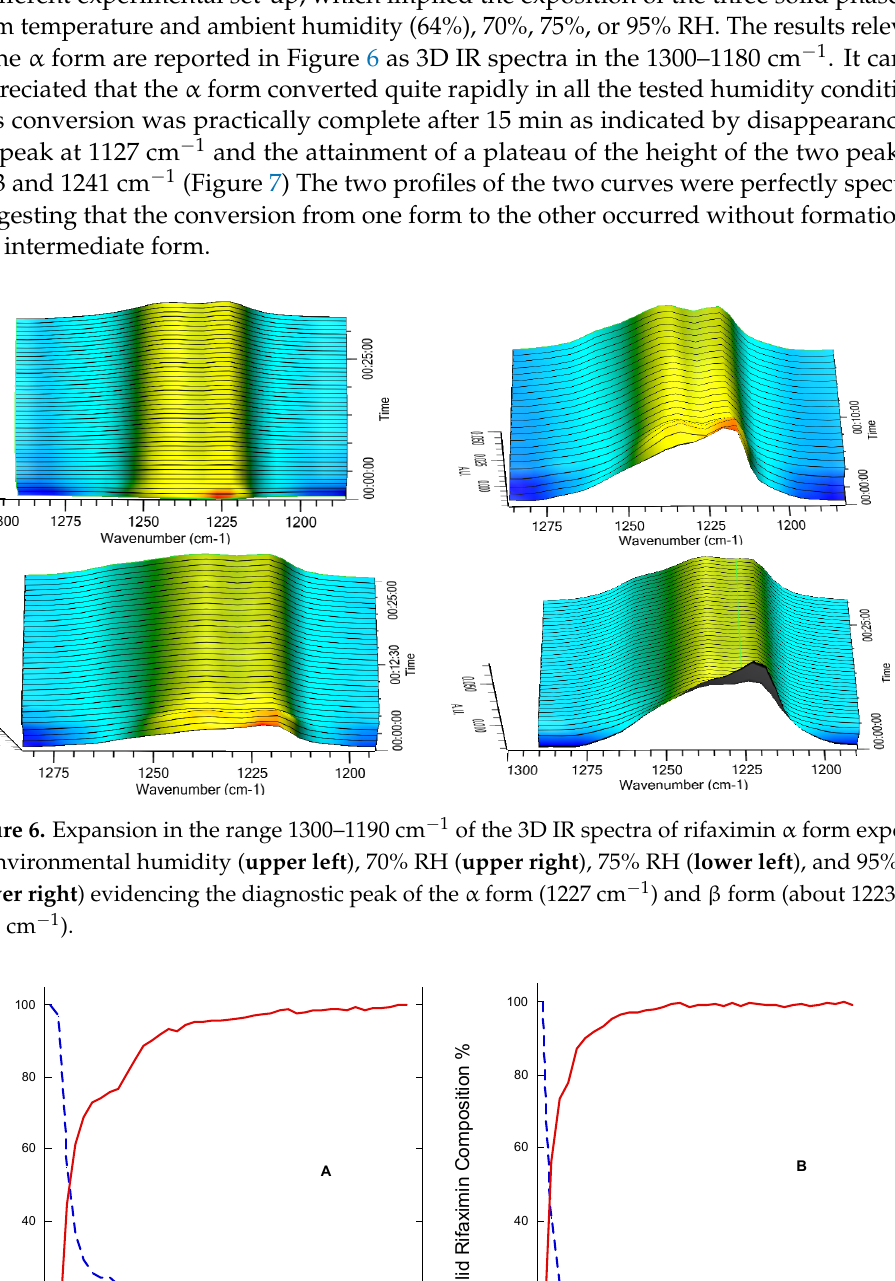
Figure 5. Concentration of rifaximin in solution at 20 °C (line with squares) from two crystalline phases (( A ), α form; ( B ), β form) and an amorphous phase ( C ) along with the height of the ATR-FT- IR peak at 1241 cm − 1 (dashed line) represented as a function of time.